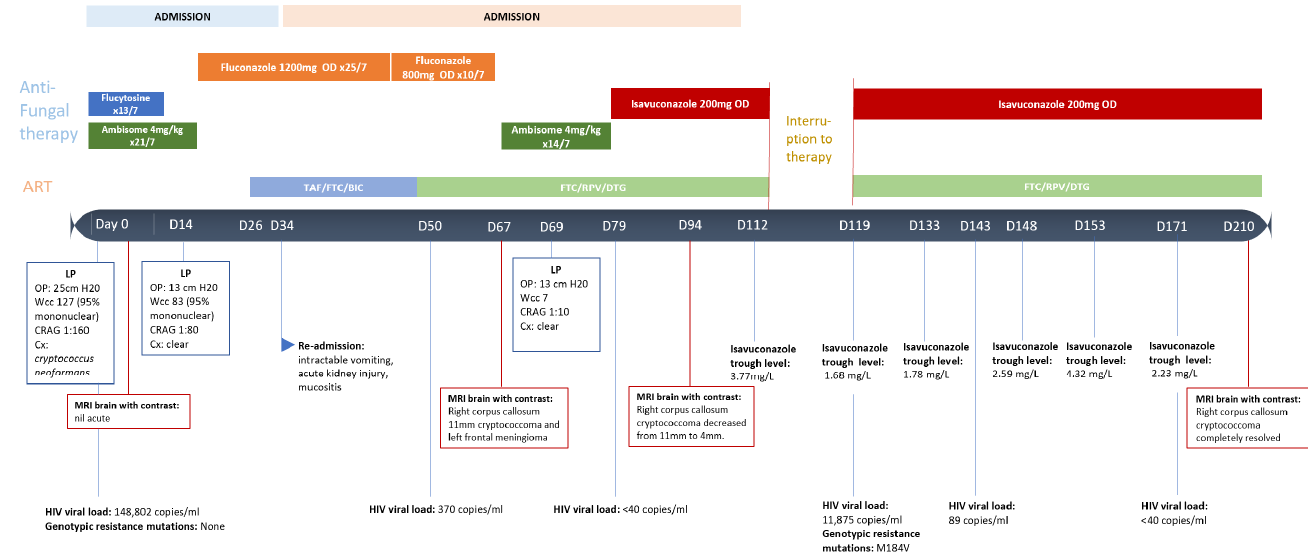
Figure 1. Timeline of patient progression.